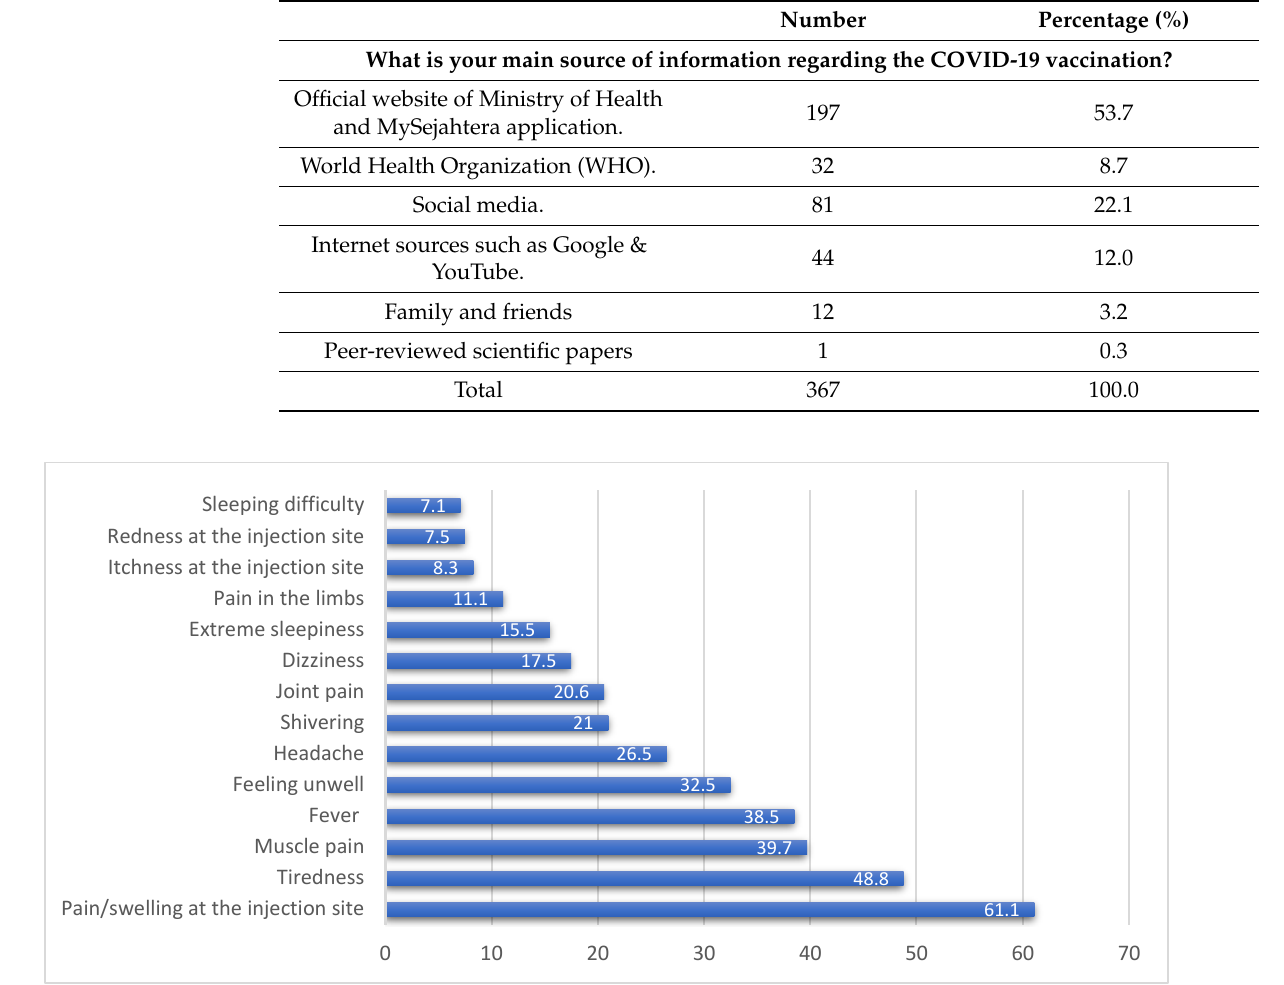
Figure 2. Percentages of commonly reported side effects of the COVID-19 vaccination.